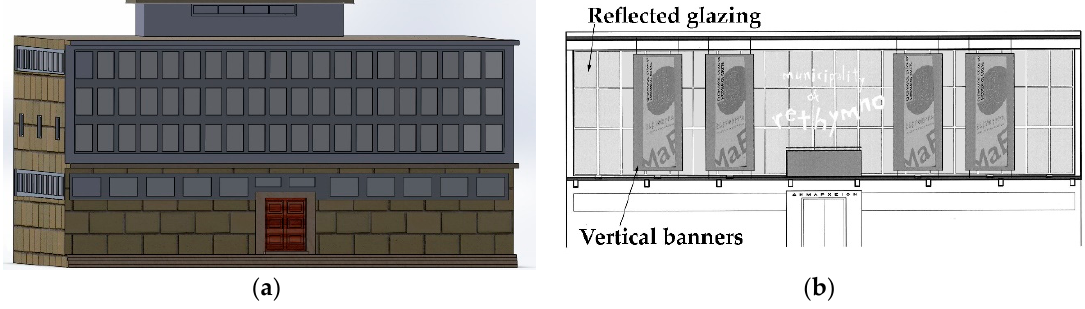
Figure 7. ( a ) Here, a 3D view of the municipality building with the southern oriented Municipal Hall. ( b ) Proposed shading measures of the Municipal Hall southern oriented transparent surface.